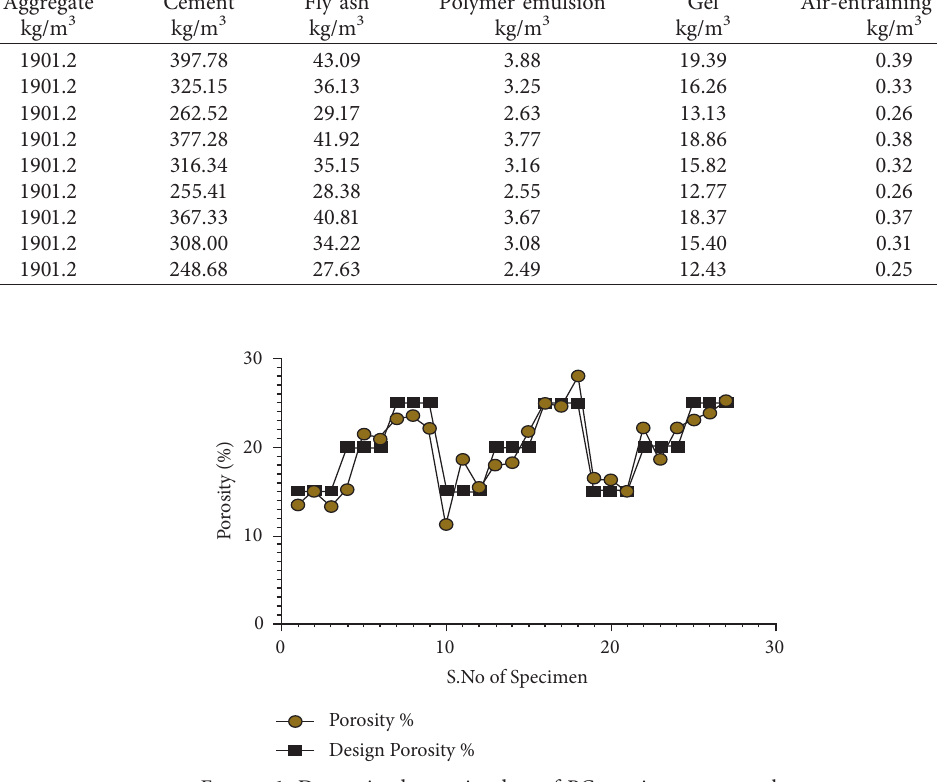
Figure 1: Determined porosity data of PC specimen test